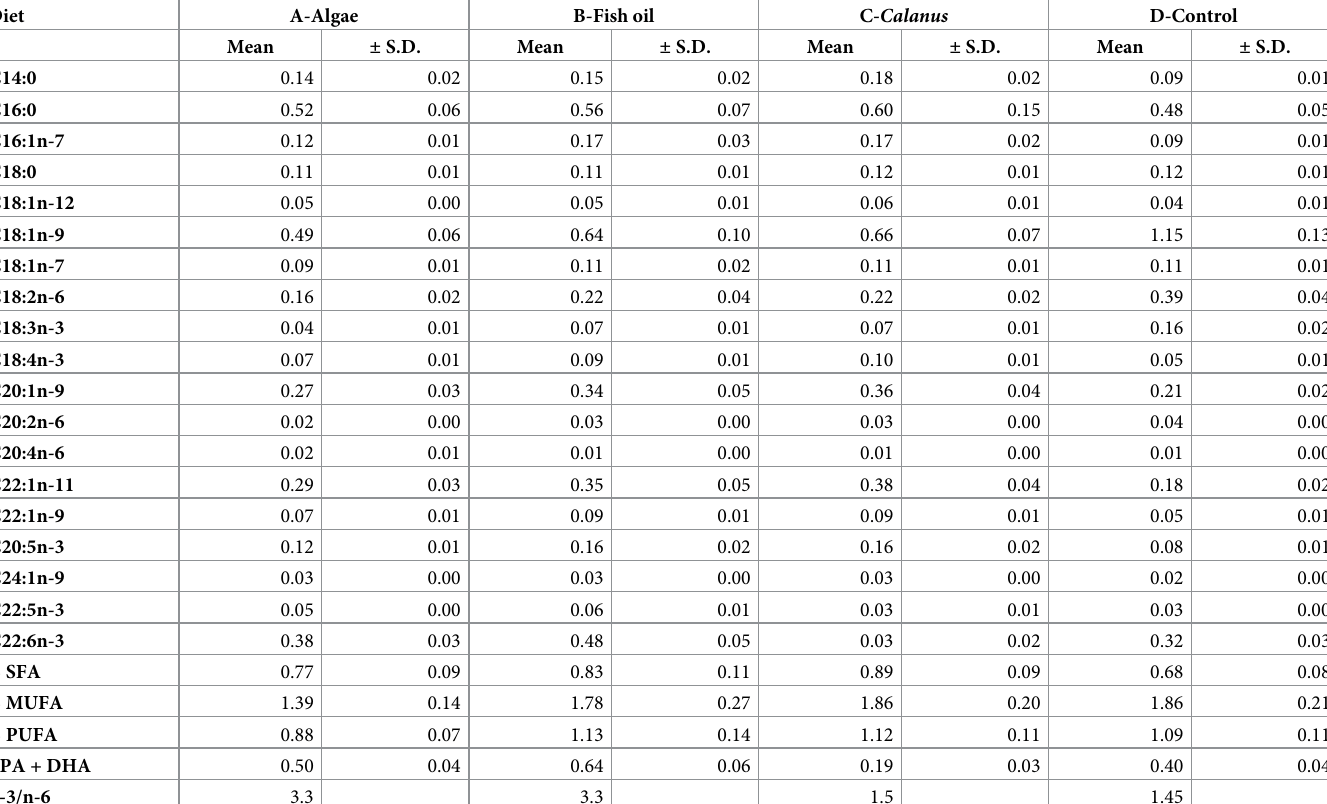
Table 8. Amount of fatty acid (g per 100g of flesh) in Atlantic salmon juveniles ( Salmo salar L .) fed diet A, B, C and D after 67 days of feeding, n =